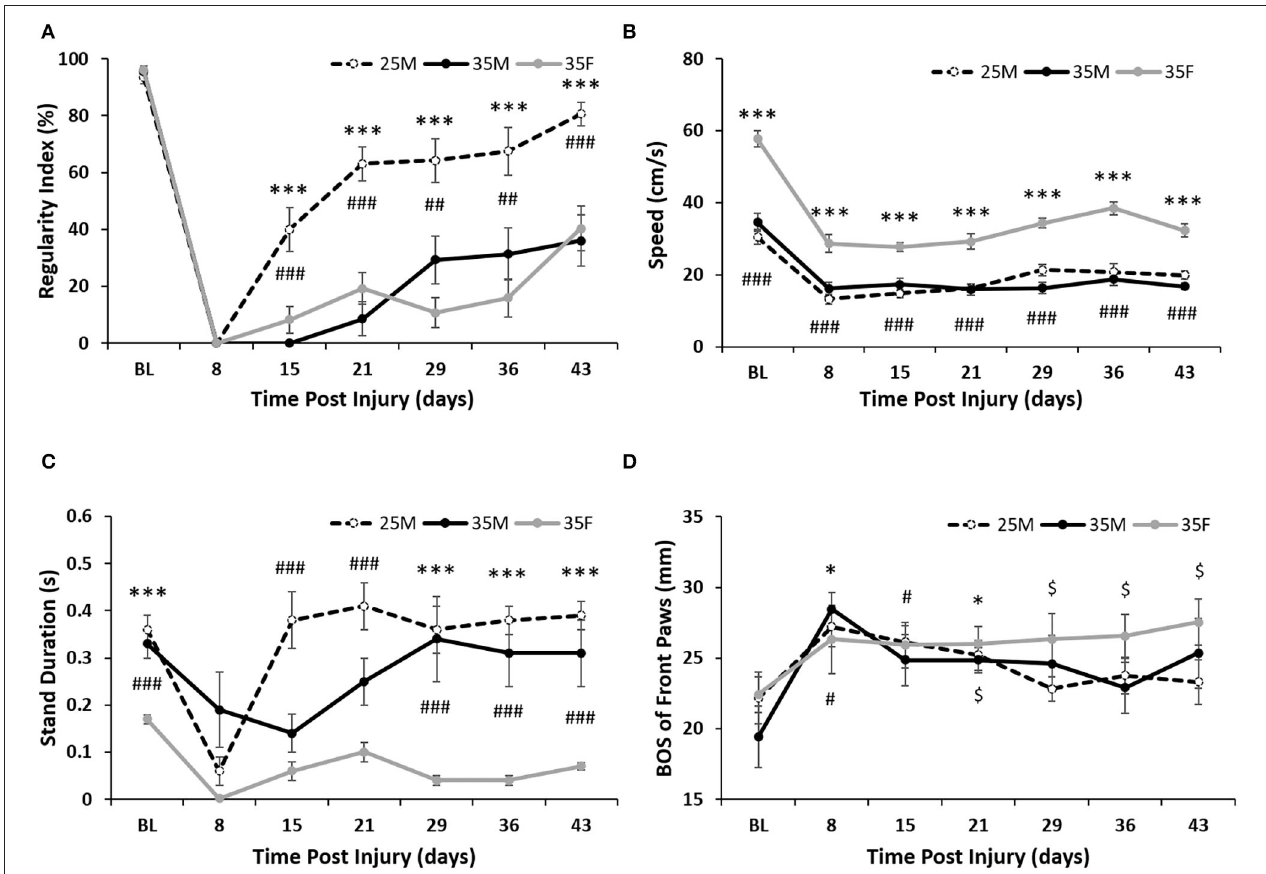
FIGURE 3 | Gate analysis following SCI. (A) Regularity index for the hind paws as calculated by the CatWalk software. Data are presented as mean ± SEM (*** p < 0.001 comparing the 25M and 35F groups; ## p < 0.01, ### p < 0.001 comparing the 25M and 35M groups; one-way repeated ANOVA with Bonferroni post-hoc analysis). (B) Average crossing speed (cm/s) as calculated by the CatWalk software. Data are presented as mean ± SEM (*** p < 0.001 comparing the 35F and 25M groups; ### p < 0.001 comparing the 35F and 35M groups; one-way repeated ANOVA with Bonferroni post-hoc analysis). (C) Average stand duration for the hind paws as calculated by the CatWalk software. Data are presented as mean ± SEM (*** p < 0.001 comparing the 35F and 35M groups; ### p < 0.001 comparing the 35F and 25M groups; one-way repeated ANOVA with Bonferroni post-hoc analysis). (D) Base of support (BOS) for the front paws as calculated by the CatWalk software. Data are presented as mean ± SEM (* p < 0.05 comparing the 35M group with baseline; # p < 0.05 comparing the 25M group with baseline; $ p < 0.05 comparing the 35F group with baseline; Wilcoxon analysis).